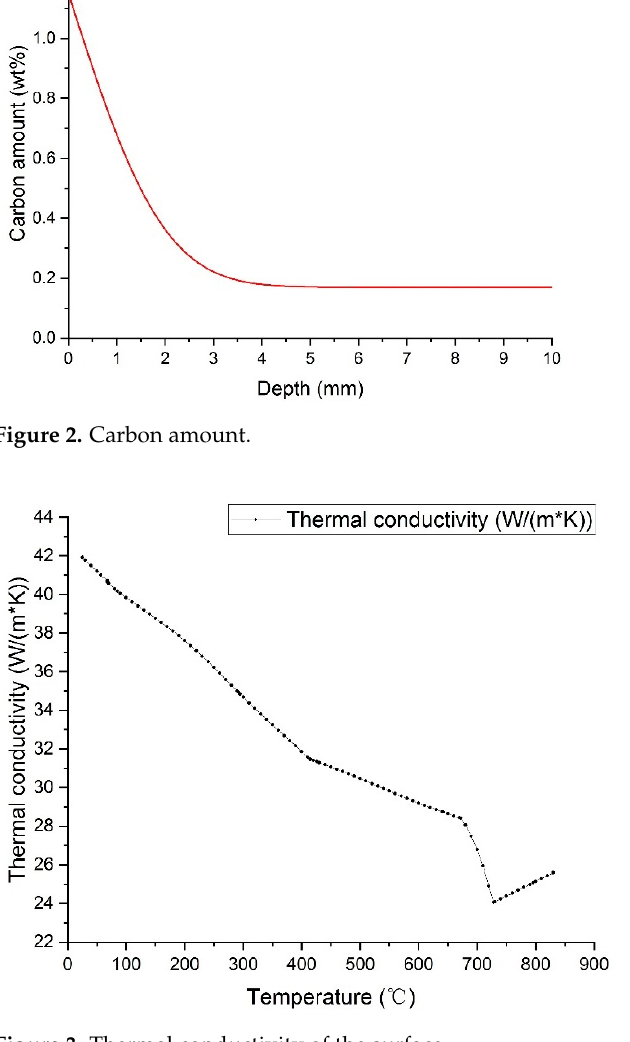
Figure 4. Specific heat of the surface. 3.2. Procedure of Simulation on the Temperature Field during Quenching The quenching temperature field is simulated by the software MSC.Marc, which is based on the finite element [25]. The mesh distribution of finite element is shown in Table 2. After simulation, the cooling rates of quenching will be obtained according to the chemical composition of different layers. To obtain the more precise result, three surfaces are divided into smaller sets, as in Table 3. From Figure 5, the changes in temperature and time will be achieved. The distribu- tion curve shows the variation trend of every node. For a better view, we set node 1 as an example. The cooling condition is shown in Figure 6. For the first node, as an example, the temperature changes rapidly at the beginning of quenching, and slowly as time passes.